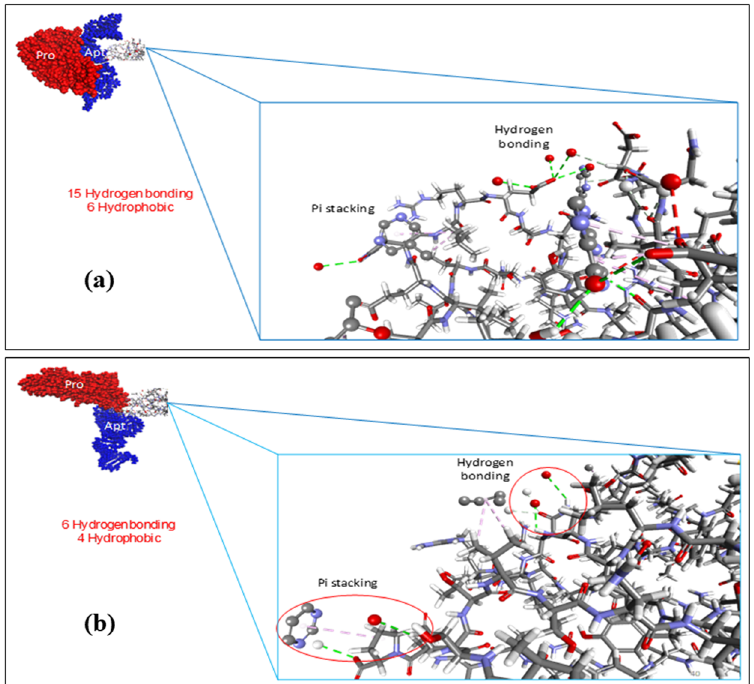
Figure 5. The interaction of the protein-aptamer in: ( a ) 310.7 K involving 15 hydrogen bonds and 6 hydrophobic interaction; and ( b ) 298 K involving 6 hydrogen bonds and 4 hydrophobic